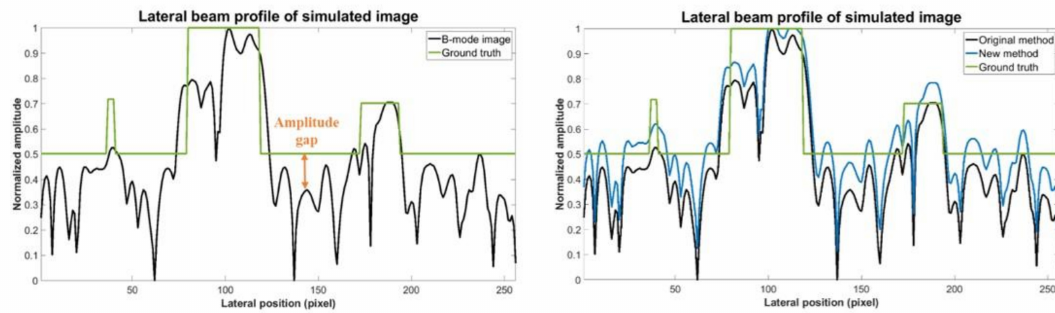
Figure 11. Ground truth echogenicity map and lateral profiles of the simulated B-mode images of the two normalization methods.